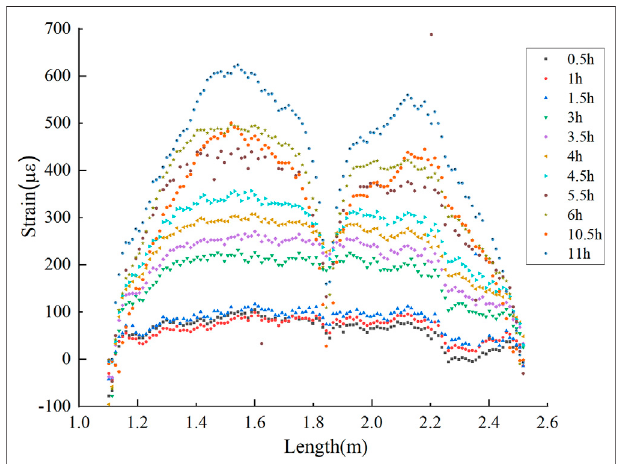
FIGURE 9 | Distributed strain measured by the optic fi ber at 0 o ’ clock position.